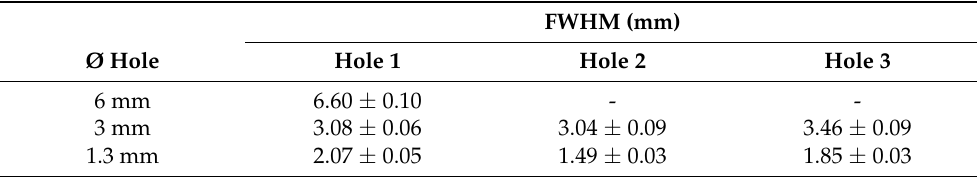
Figure 11. The line-average response profile of 1.3 mm diameter holes spaced by 1 mm (edge to edge). The FWHM of the Gaussian distribution of the three holes (Table 1) were obtained by fitting the profile by a triple Gaussian function. Table 1. Calculated FWHM of the 1D profiles for three regions of interest of the images obtained by the GEMPix and the 1 mm-thick copper